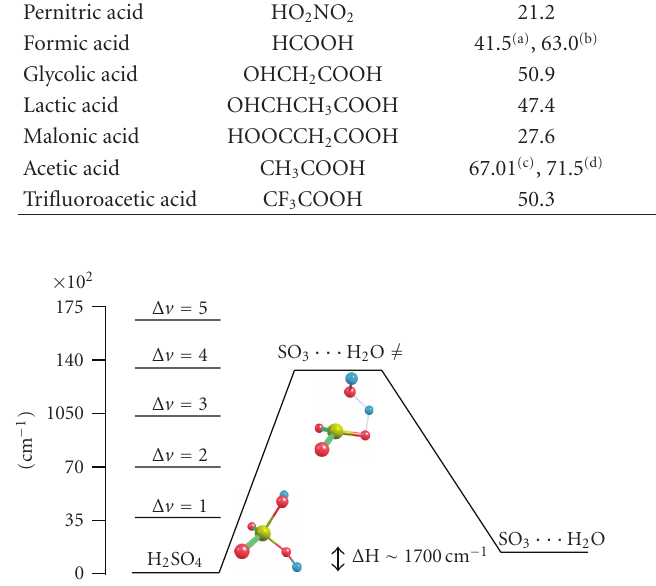
Figure 4: Calculated energy barrier for sulfuric acid